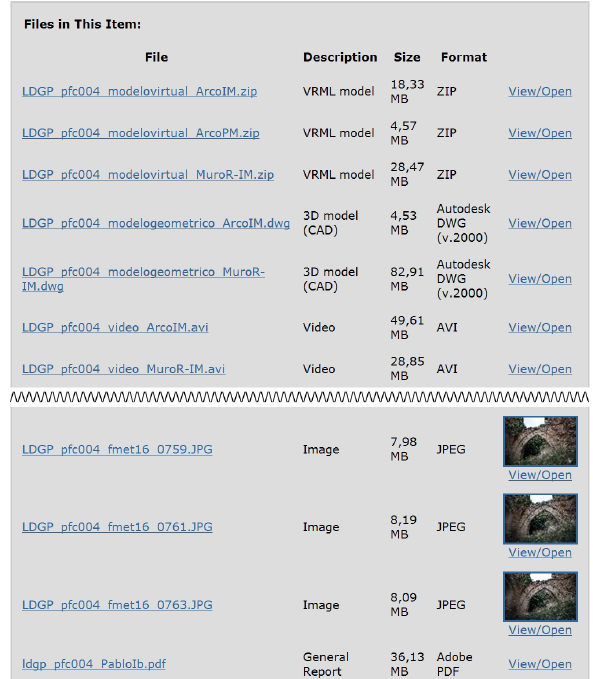
Figure 7. Different types of files included in a record (http://hdl.handle.net/10810/7083 20 Jun. 2013)